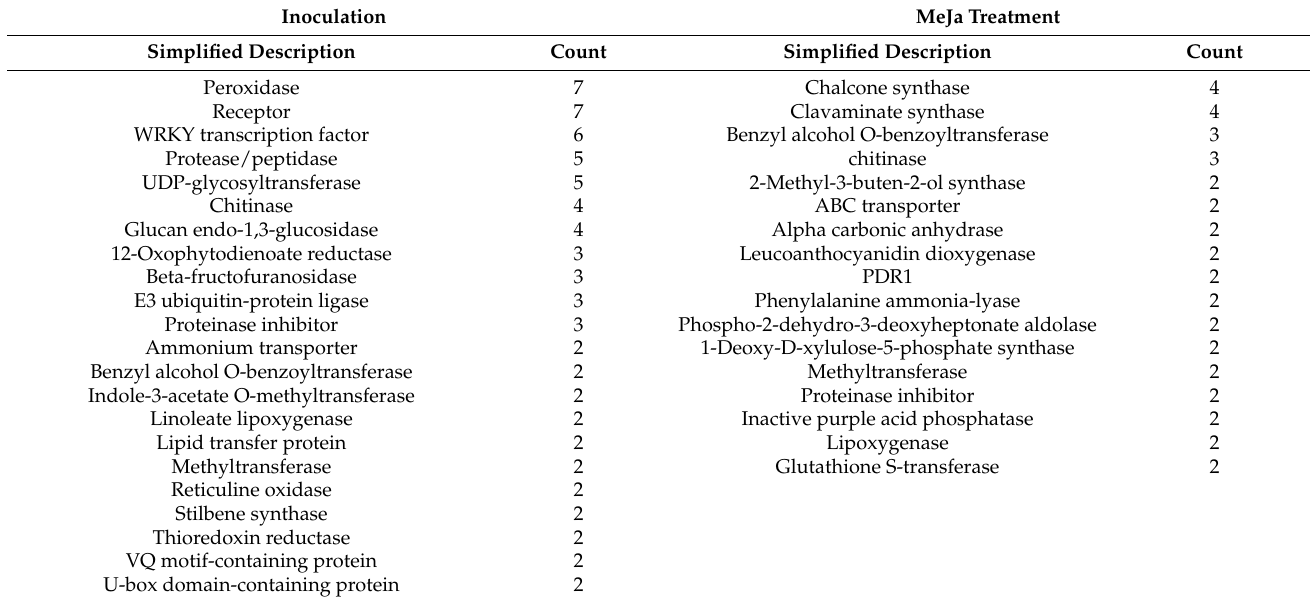
Table 13. Comparison of most frequent simplified Blast2GO annotations of upregulated DEGs between the inoculation and MeJa treatment experiments (total number of upregulated DEGs after inoculation = 164, upregulated DEGs after MeJa treatment =